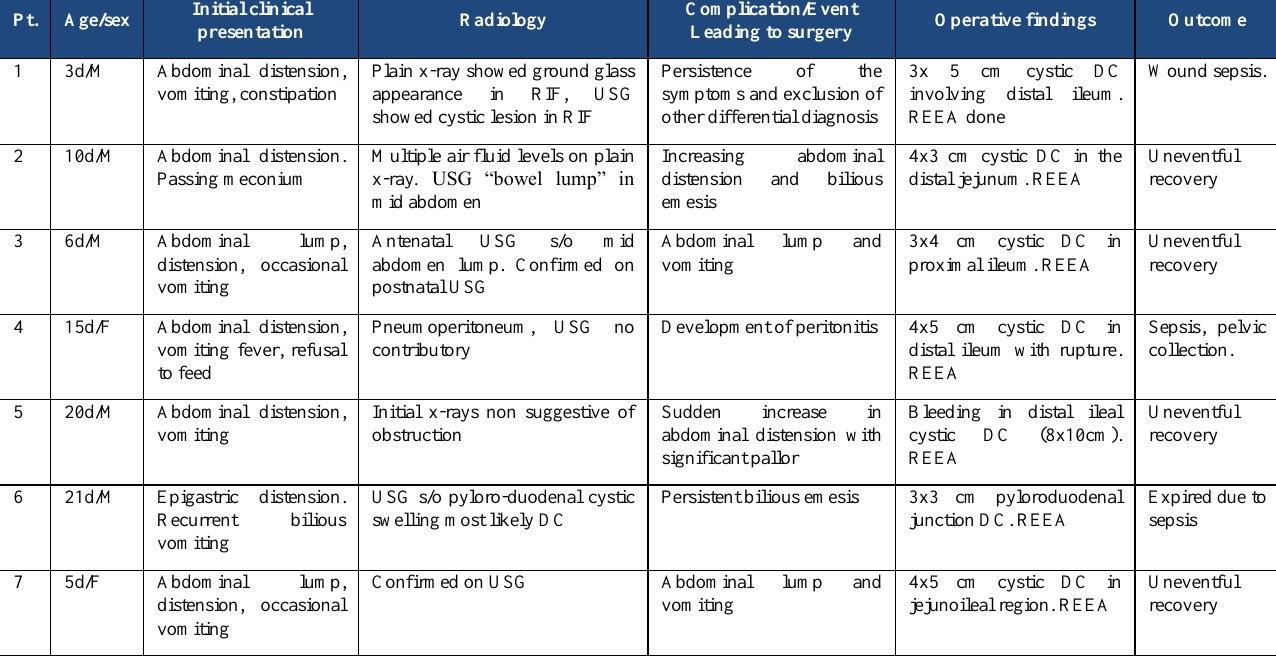
Table 1: showing the demographic and clinical profile of the